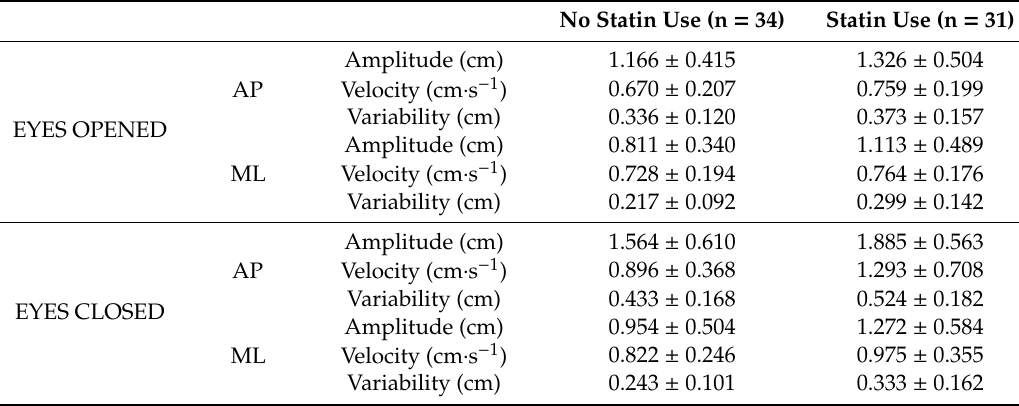
Table 2. Balance performances according to statin use (means ± standard deviations).